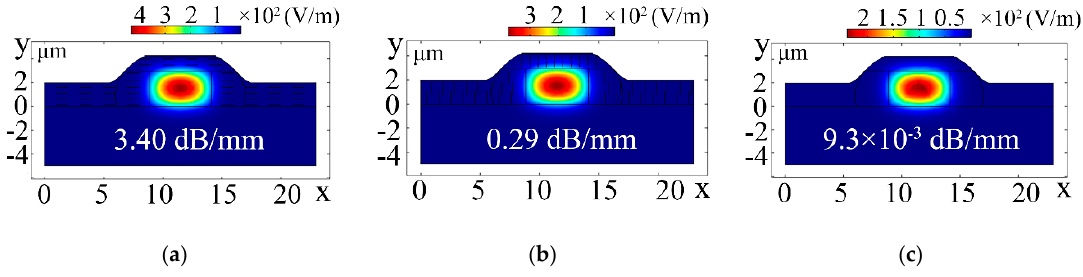
Figure 3. Light field distributions of the dispersed-monolayer graphene arrangement in the ( a ) x -direction and ( b ) y -direction, and the ( c ) ND-TO switch.